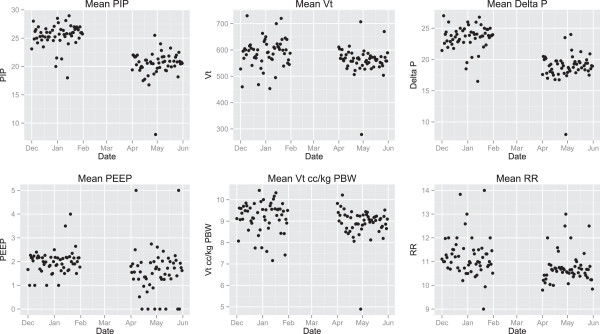
Scatterplots of average ventilation parameters over 2 months before and 2 months after new machines are integrated into practice. Significant changes were seen in peak inspiratory pressure (PIP) and drive pressure (∆P). Vt = tidal Volume, PEEP = positive end expiratory pressure, RR = respiratory rate.